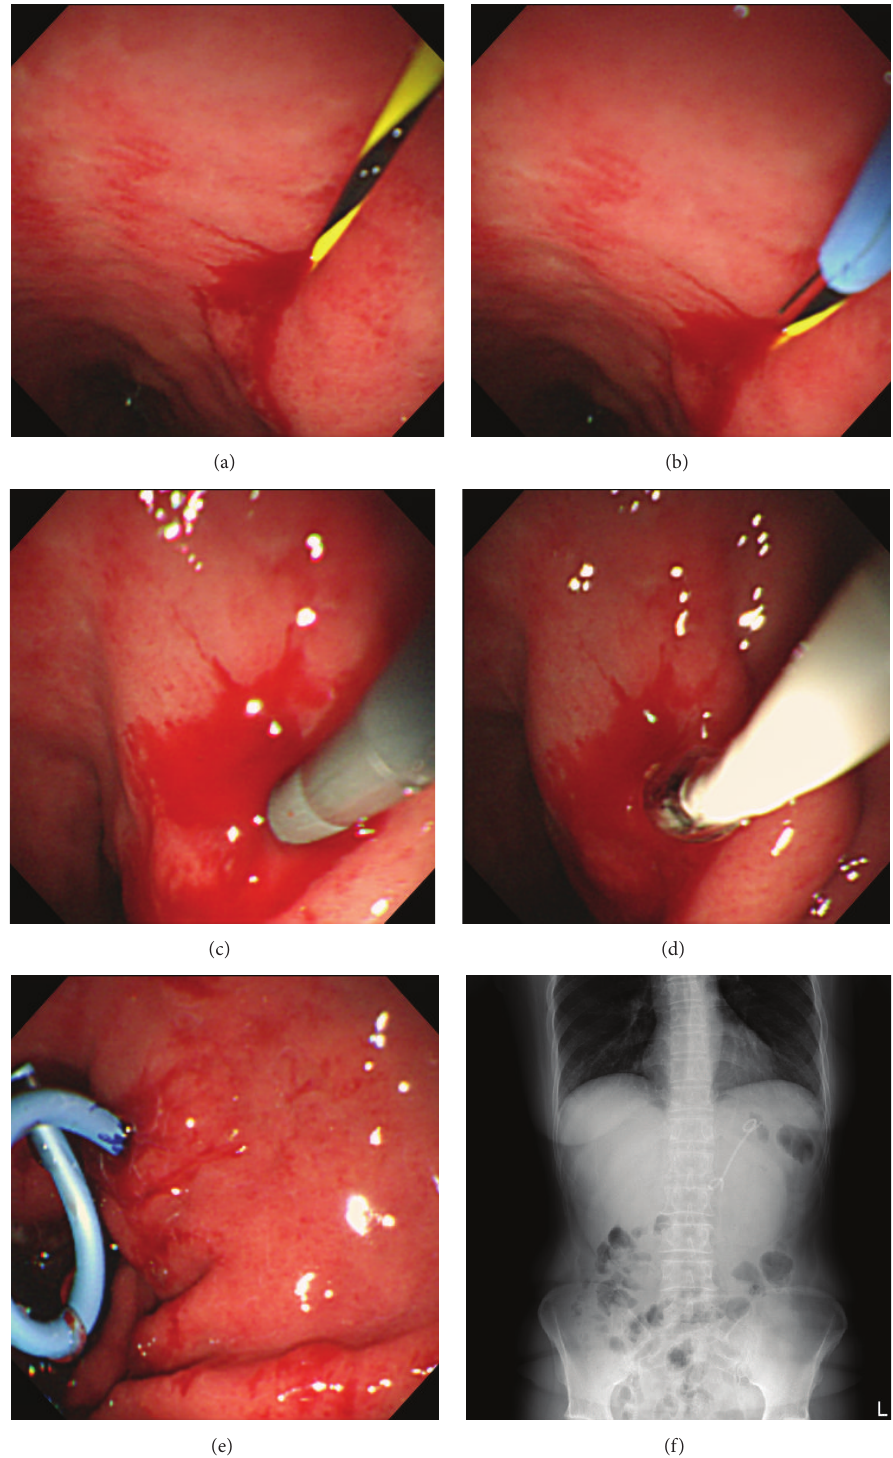
Figure 2: Endoscopic images (a–e) and radiologic image (f). (a) Placement of a 0.035-inch guidewire into the cavity. (b) Transmural incision using electrocautery administered via an over-the-wire needle-knife catheter under endoscopic view. (c) Bougienage with 7 Fr biliary dilatation catheters. (d) Sequential dilatation using a 4 mm × 40 mm wire-guided Hurricane RX Balloon Dilator under endoscopic guidance. (e) Transgastric placement of a 7 Fr pigtail stent to drain the pseudocyst. (f) X-ray view of a 7 Fr pigtail stent after endoscopic ultrasound- guided